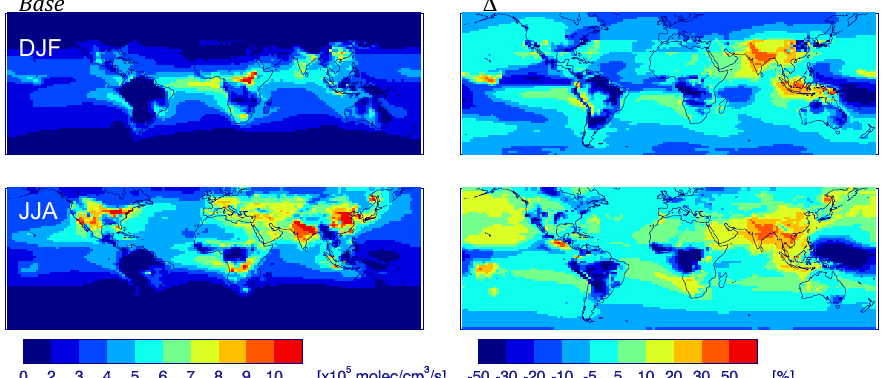
Figure 20. Seasonal mean (1988–2007), mass-weighted tropospheric CO loss rates (left column; × 10 5 moleculescm − 3 s − 1 ) from the Base scenario, and relative difference (%) between the Base and AllVary scenarios (( Base–AllVary ) / Base ; right